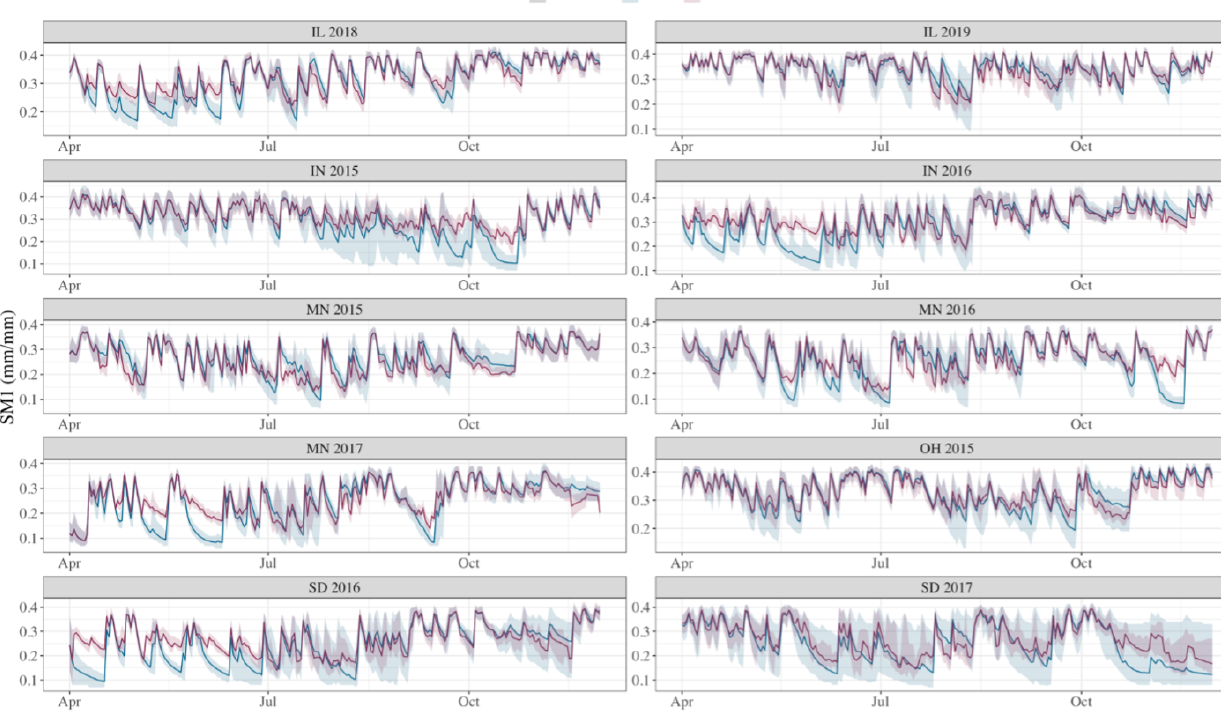
Figure 7. Time series of SM1 estimates from the free model and RS-SDA with the mean daily estimates demonstrated with line graphs. The shaded regions indicate 95% credibility